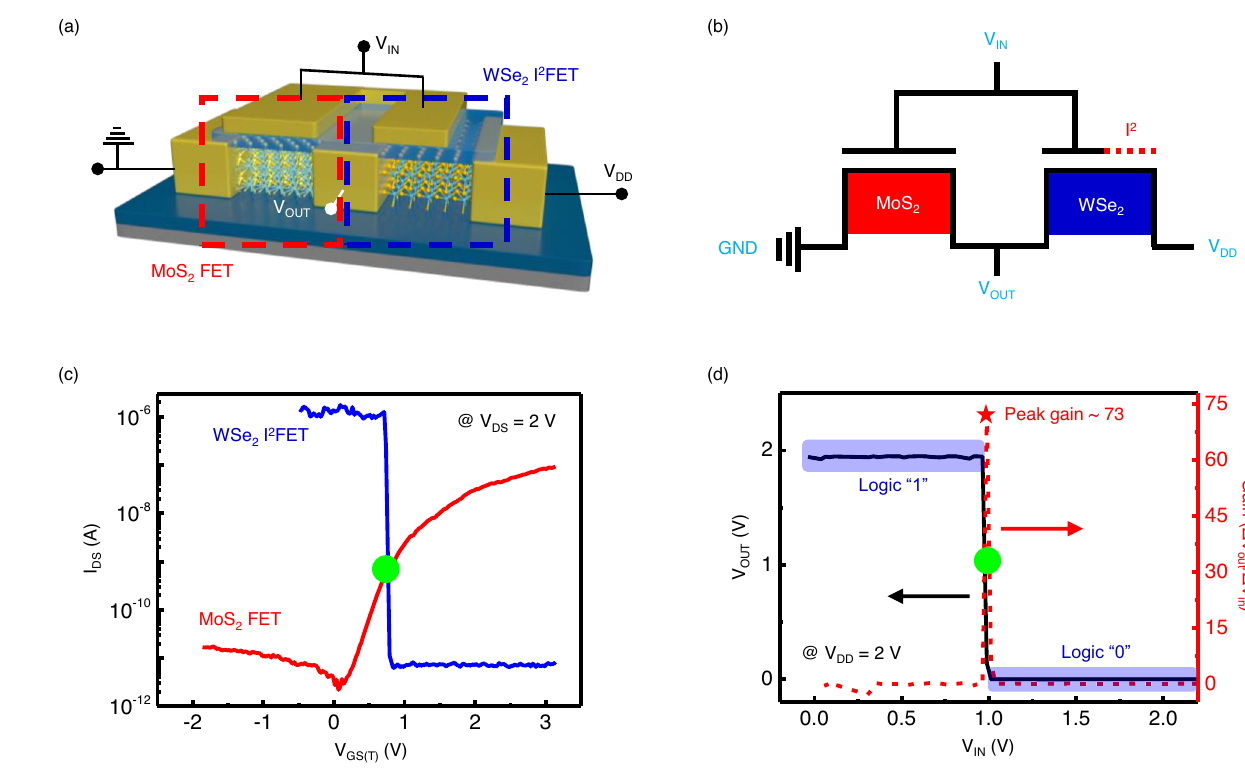
Fig. 5 | Complementary inverter fabricated with WSe 2 I 2 FET. a Schematic of a complementary inverter consisting of an n-type MoS 2 driver transistor and p-type WSe 2 I 2 FET pull-up transistor. ( V IN and V OUT : input and output voltages shared by the two transistors, V DD : power supply voltage) b Circuit con fi guration of the